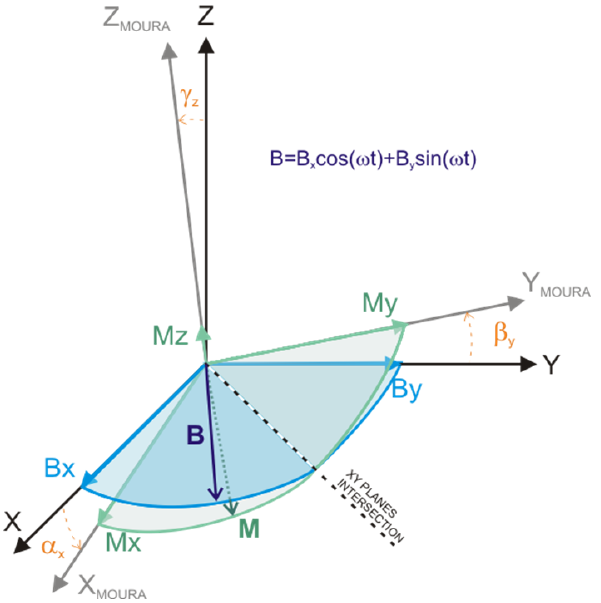
Figure 5. Sketch of the different shapes of magnetic field measured in external and MOURA reference systems.